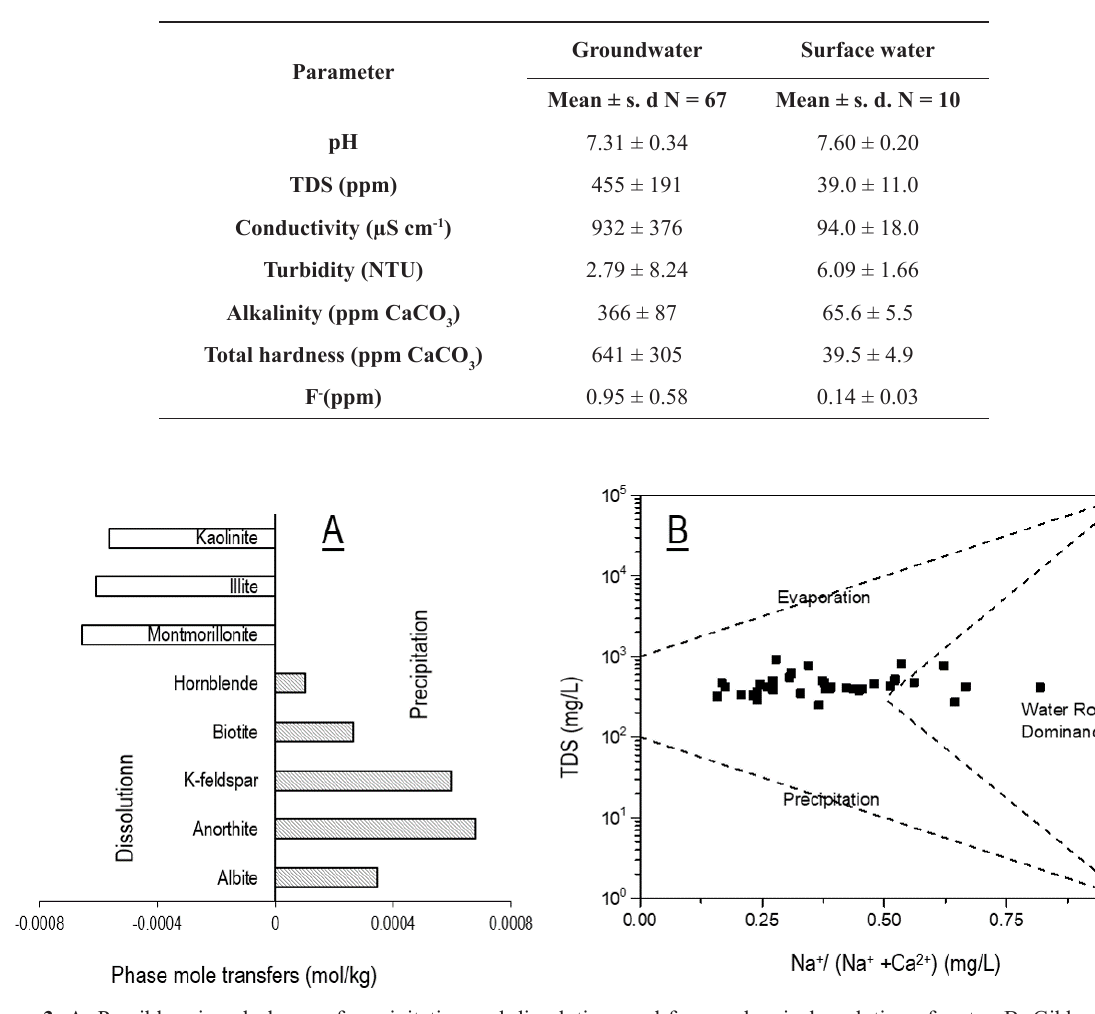
Figure 3: A. Possible mineral phases of precipitation and dissolution used for geochemical evolution of water. B. Gibbs diagrams showing different physicochemical